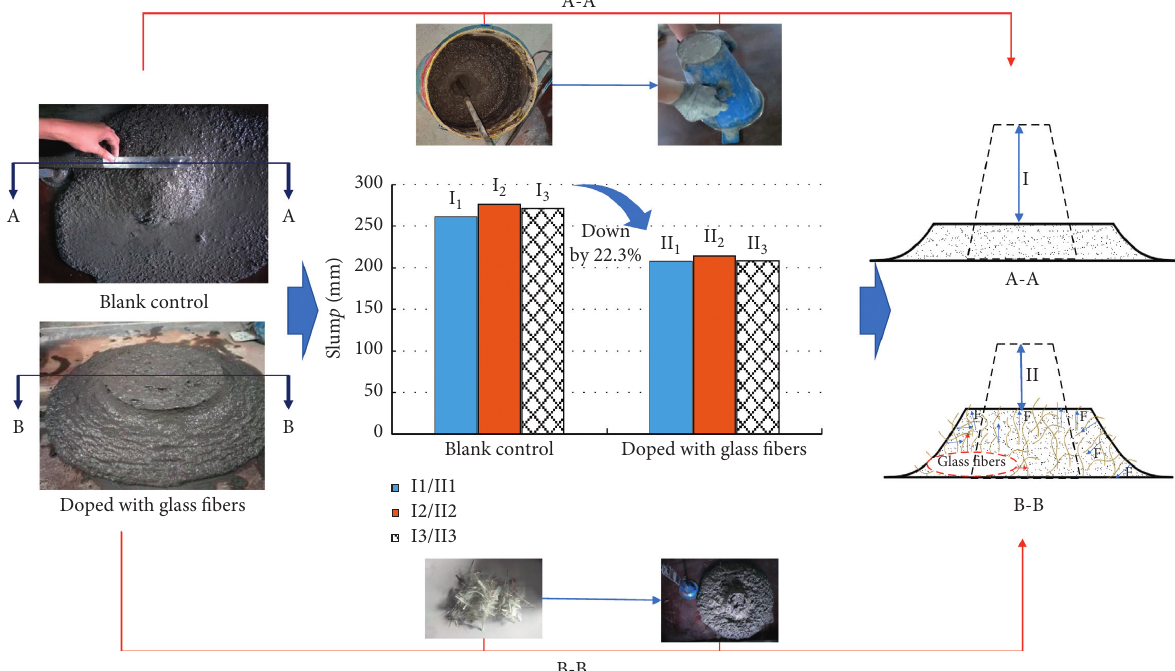
Figure 8: Schematic diagram of the influence mechanism of doped glass fibers on the